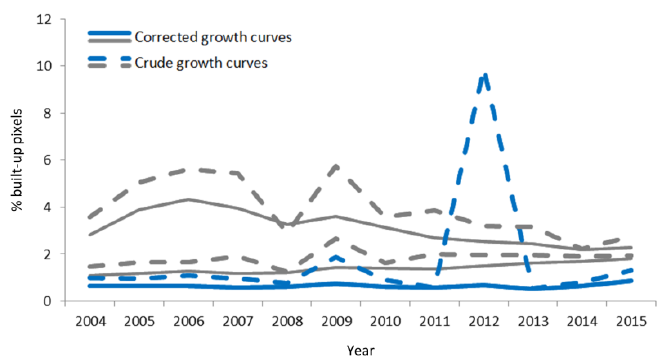
Figure 5. Visualization of the impact of the temporal consistency correction. Crude growth curves are depicted with dashed lines; corrected growth curves with solid lines. This example shows the trends in the 10 km buffer around the Bissa mine (blue line) and its comparison areas (grey lines).